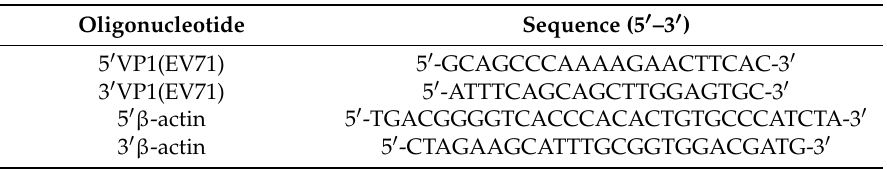
Table 2. Oligonucleotides used for real-time RT-PCR.